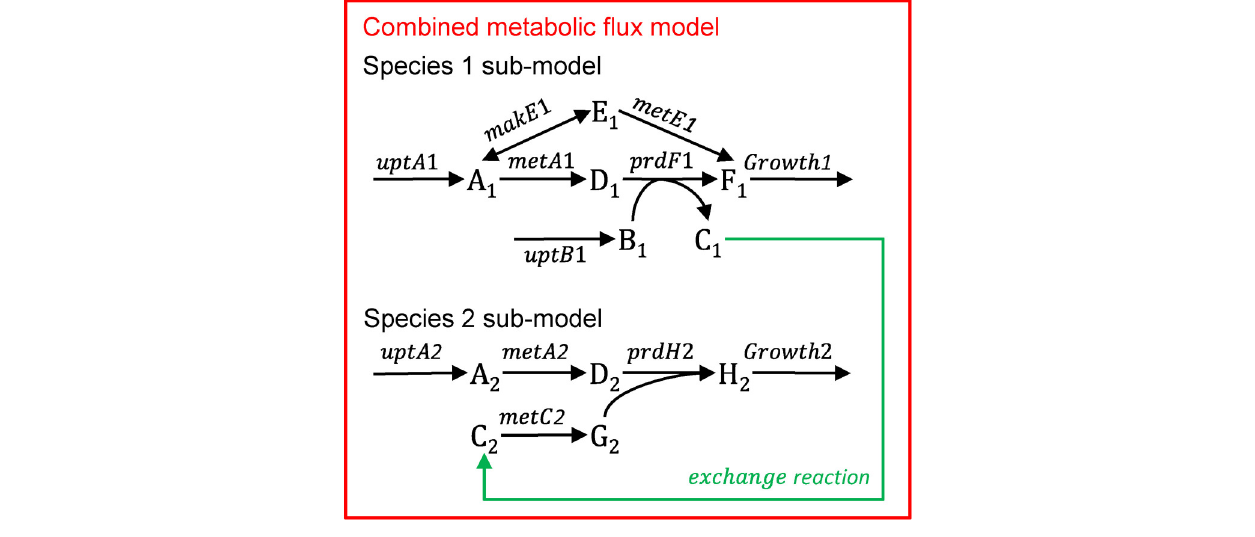
FIGURE B1.2 | Multi-species metabolic flux modeling—directly linked model. After Figure 2 in Stolyar et al. (2007). The metabolic models for each species ( Figure B1.1 ) are combined into one model, with exchange reactions linking their metabolisms.